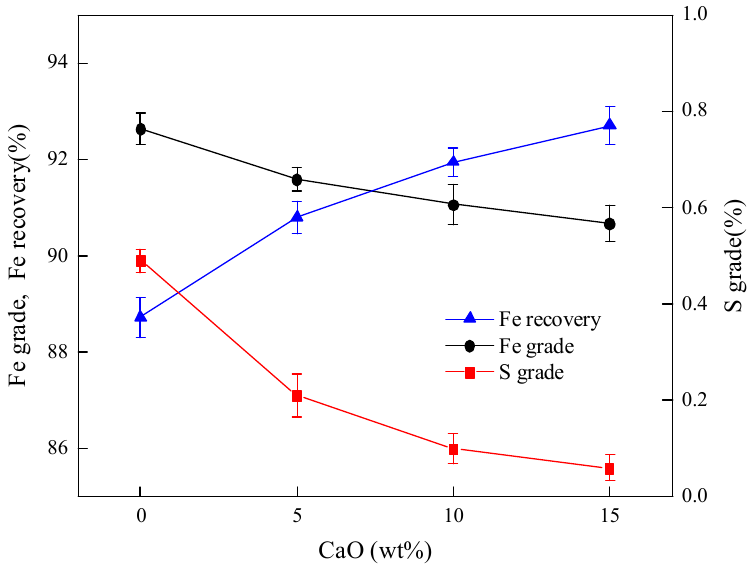
Figure 11. Effect of the different added amounts of CaO on reduction iron product index. SEM analysis was performed on the reduced iron products obtained without CaO and 15 wt% CaO, as shown in Figures 12 and 13 and Tables 7 and 8. Figure 12 and Table 7 show that, after grinding and magnetic separation, the reduced iron product without CaO contained more sulfur (troilite). The troilite and metallic iron particles were densely embedded, and it was not easy to realize the monomer dissociation through the grinding process. The troilite could not be effectively removed by the magnetic separation process, which affected the quality of the reduced iron. Figure 13 and Table 8 show that there was almost no sulfur content in the reduced iron product after adding 15 wt% CaO. The results revealed that the oldhamite was easily removed by grinding and magnetic separation, which greatly reduced the sulfur content of the reduced iron